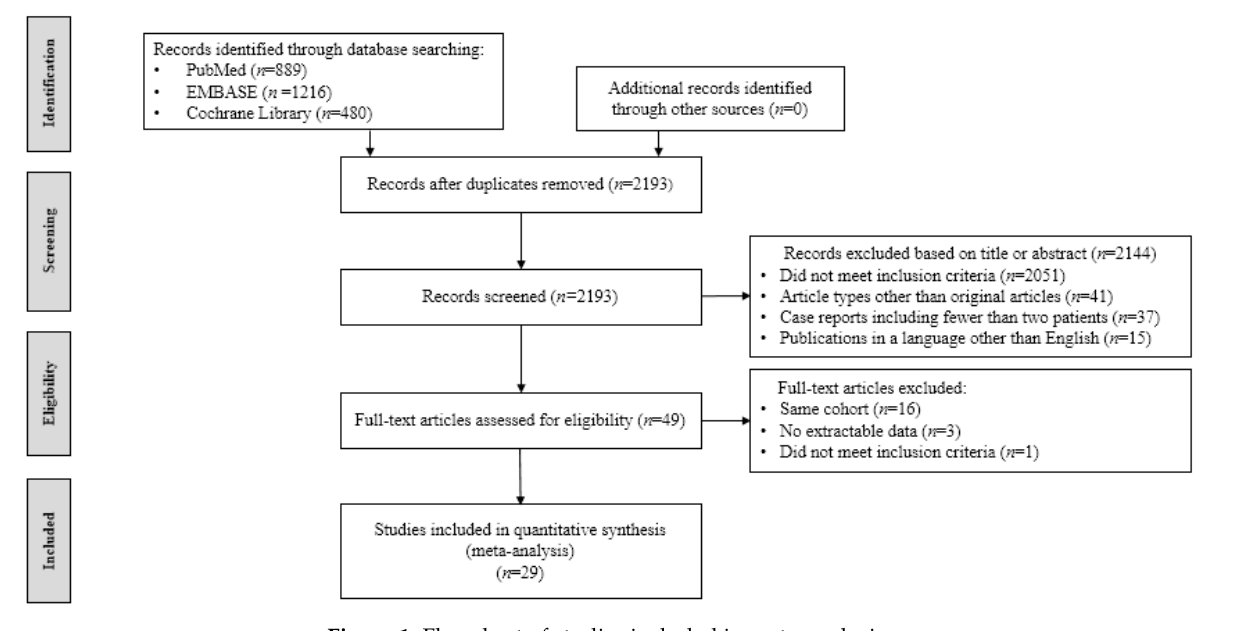
Figure 1. Flowchart of studies included in meta-analysis.